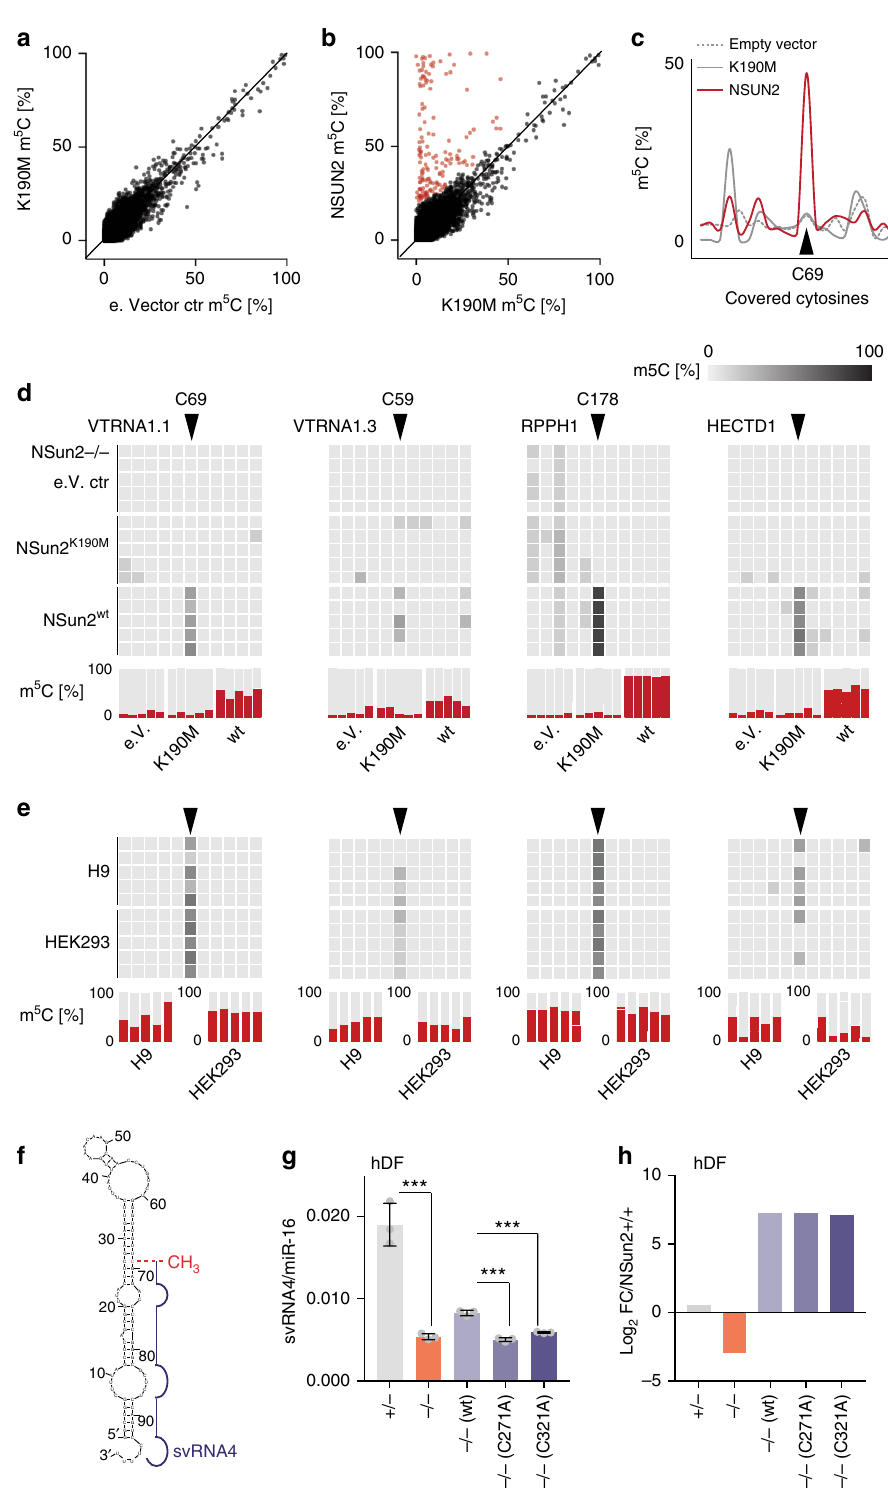
Fig. 1 Methylation of VTRNA1.1 by NSUN2 determines the biogenesis of svRNA4. a – c Correlation of site-speci fi c methylation (m 5 C) levels ( a , b ) and methylation level at all covered cytosines in VTRNA1.1 ( c ) in NSUN2 -/- cells infected with the empty (e.) vector (ctr), the enzymatic dead construct K190M or the wild-type NSUN2 construct. NSUN2-speci fi c sites are highlighted in red. d , e Heatmaps (upper panels) and methylation level (bottom panels) of VTRNA1.1, VTRN1.3, RPPH1, and HECTD1 in infected NSUN2 -/- cells ( d ), human embryonic fi broblasts (H9) and HEK293 cells ( e ). Shown are fi ve independent bisul fi te conversion experiments. f Schematic illustration of NSUN2-dependent methylation (CH 3 ) of VTRNA1.1 and the small regulatory non- coding fragments svRNA4. g Abundance of svRNA4 in the presence ( + / − ) and absence ( − / − ) of NSUN2. Methylation dead NSUN2-mutant constructs (C271A; C321A) fail to rescue svRNA4 levels in NSUN2 − / − cells. Error bars indicate s.d. ( n = 3 qRT-PCR reactions). *** p < 0.001 unpaired student ’ s t -test. h Log 2 fold-change of NSUN2 in the indicated cells compared to NSUN2 + / + control cells measured by ribosome pro fi ling. Source data are provided as a Source Data fi